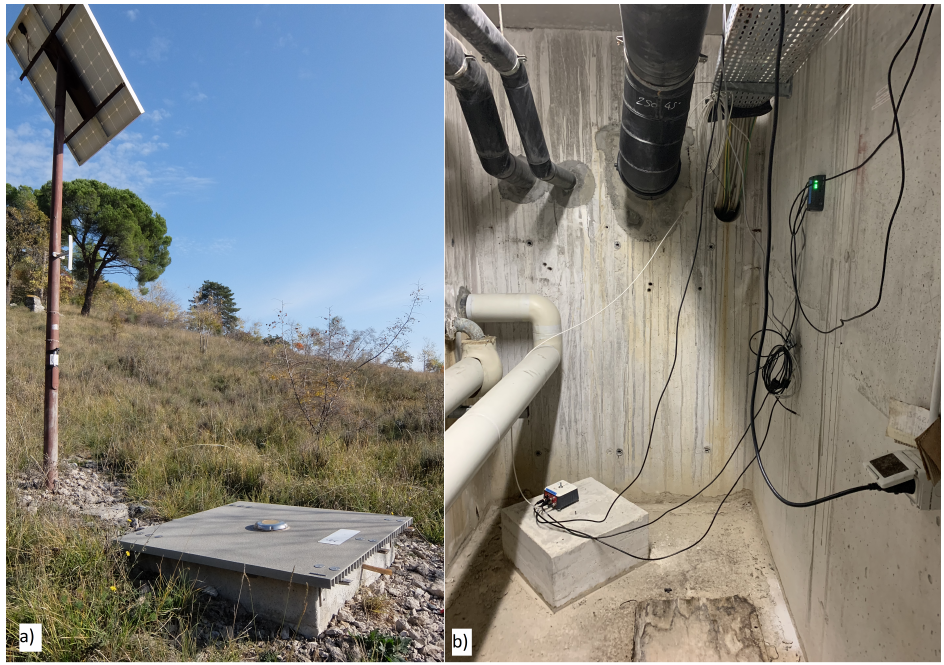
Figure 2. The two typical ( a ) free-field and ( b ) inside-buildings installations used in the RAN network. ( a ) is the the MONF station, while ( b ) is the POR